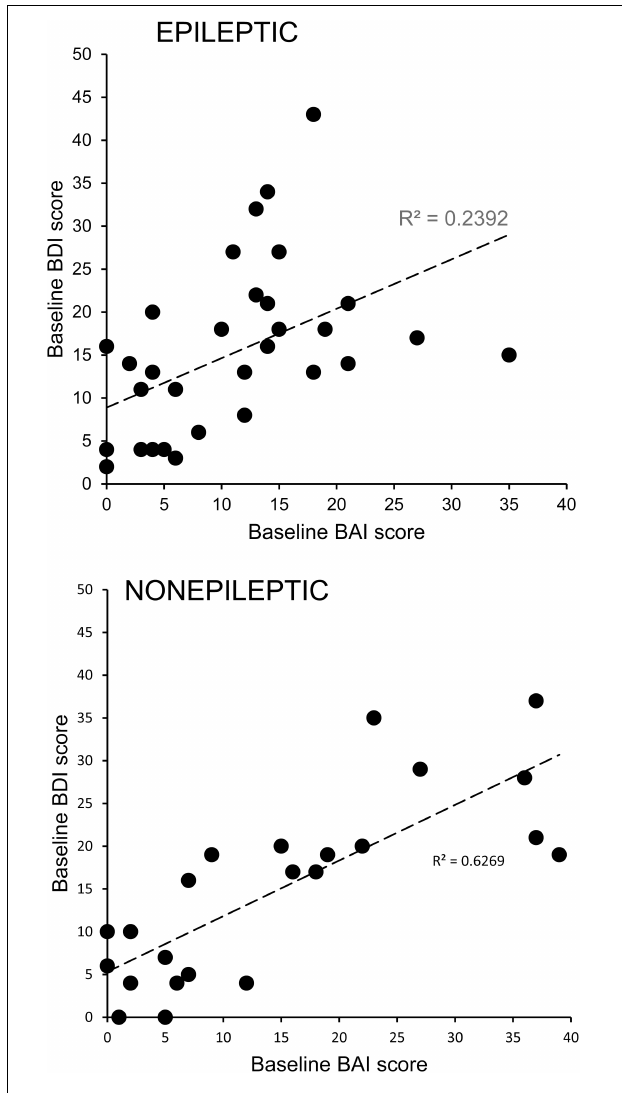
FIGURE 2 | Comorbidity of depression and anxiety symptoms in patients with epileptic and non-epileptic seizures. Depression scores for individual patients with epileptic (upper graph) or non-epileptic (lower graph) seizures as assessed with the Becks Depression Index-II (BDI) are plotted as a function of their anxiety scores as assessed with the Beck Anxiety Inventories (BAI). The positive correlations were significant for both groups (ES, Pearson p = 0.0061; NES, Pearson p < 0.00001), indicating a high degree of comorbidity.